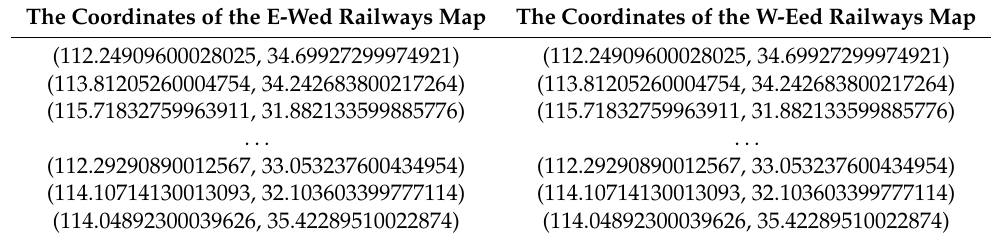
Table 3. The coordinates of the E-Wed railways map compared with the W-Eed railways map. The Coordinates of the E-Wed Railways Map The Coordinates of the W-Eed Railways